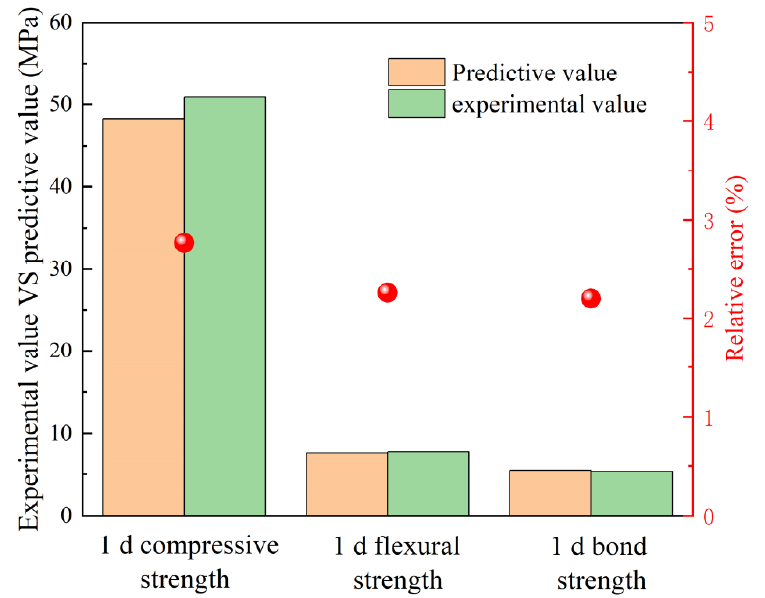
Figure 16. Verification of RSM in the optimal condition.